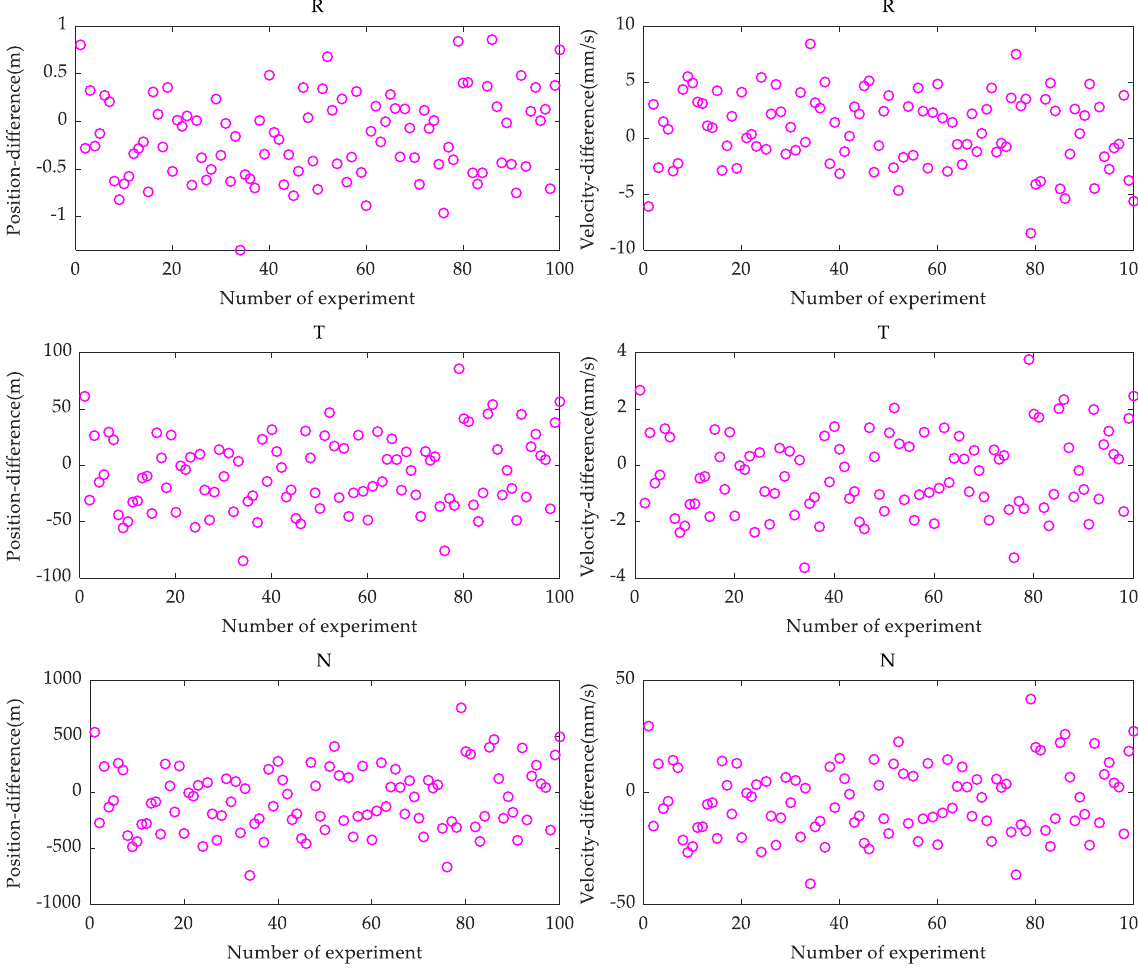
Figure 3. The orbital difference between initial spacecraft states computed with Doppler data and a “true” initial spacecraft state. “R”, “T”, and “N” denote radial, tangential, and normal directions, respectively. (Left: position difference, Right: velocity difference).